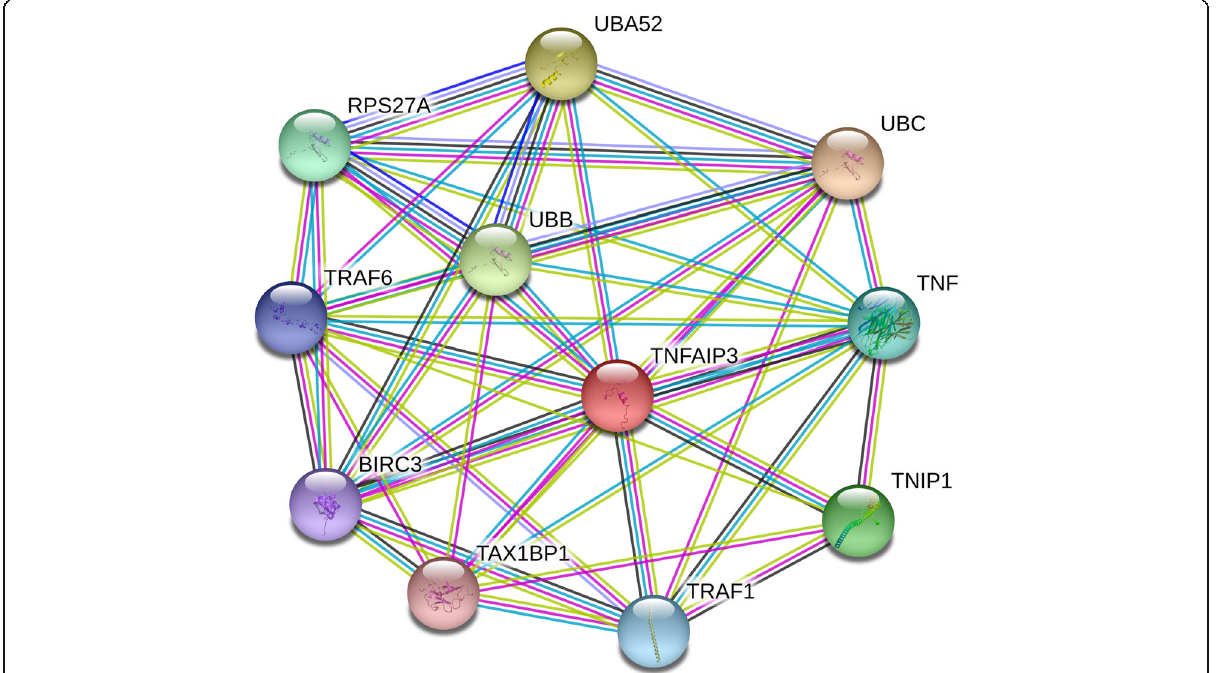
Fig. 1 Network of TNFAIP3, TNIP1 and their closest functional partners. These data were from the Search Tool for the Retrieval of Interacting Genes (STRING) database